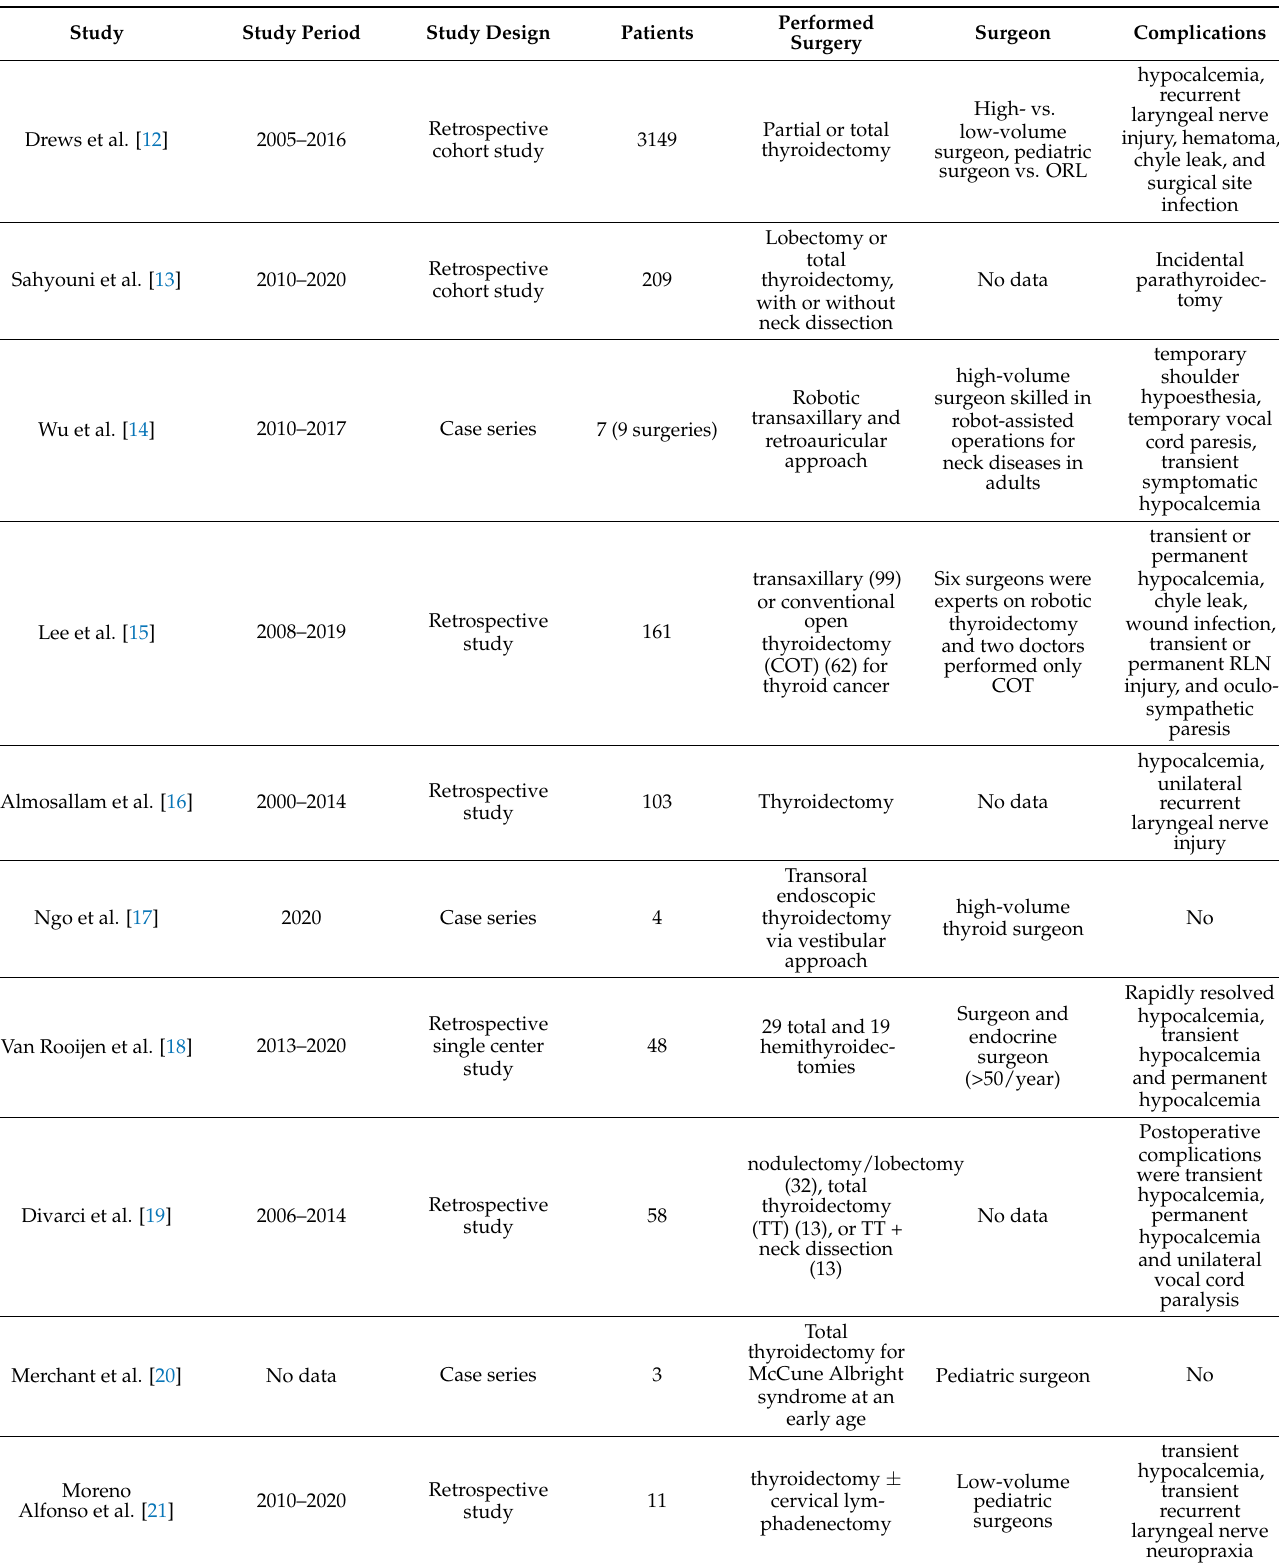
Table 3. Review of the literature